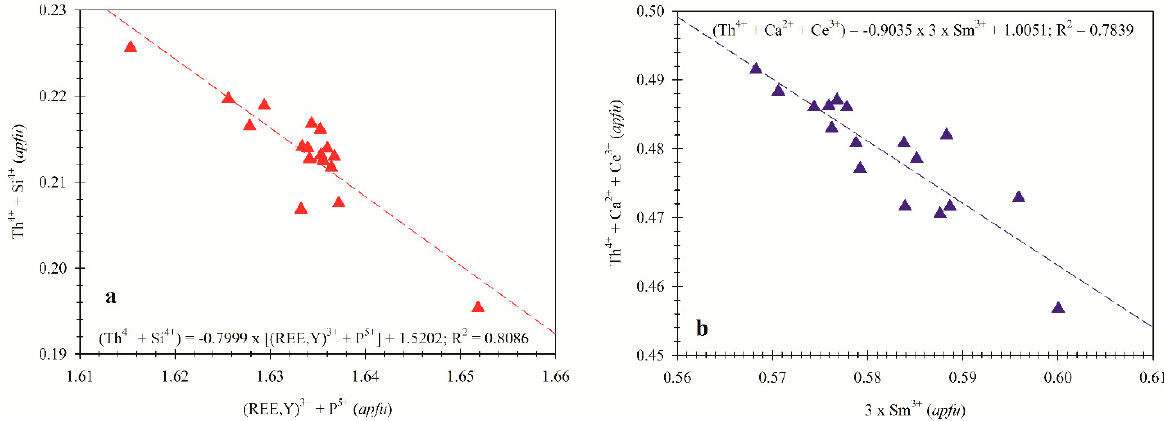
Figure 4. Compositional exchanges in sample 4a. Two negative exchanges are observed: ( a ) (REE,Y) 3+ + P 5+ ↔ Th 4+ + Si 4+ (huttonite substitution) and ( b ) 3Sm 3+ ↔ Ce 3+ + Th 4+ + Ca 2+ .